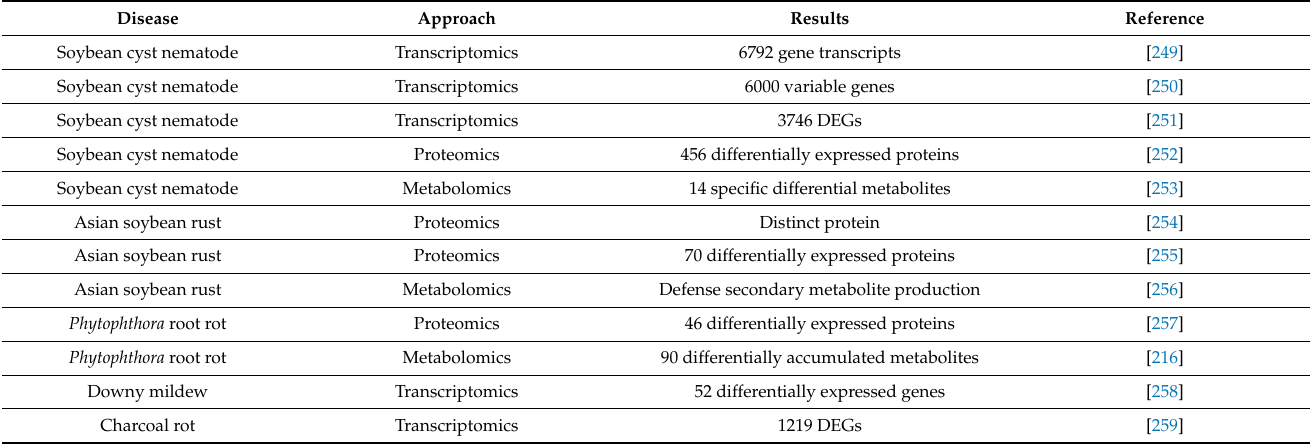
Table 3. Advanced approaches and their application in biotic stress resistance in